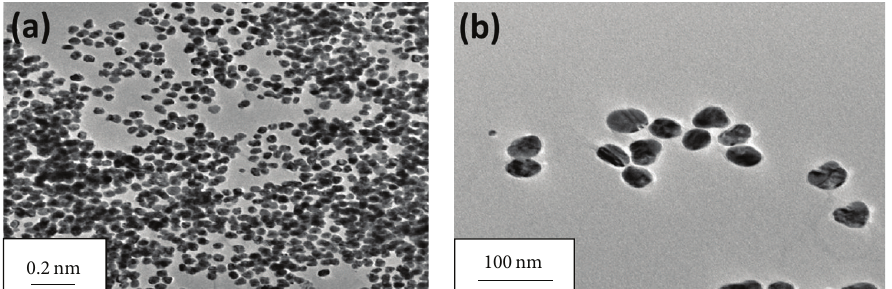
Figure 4: TEM images of Ag NPs synthesized with Elaeagnus Latifolia as a reducing agent: (a) overview of Ag NPs and (b) higher magnification image of the Ag NPs showing defects [46] (reproduced with permission from the journal).